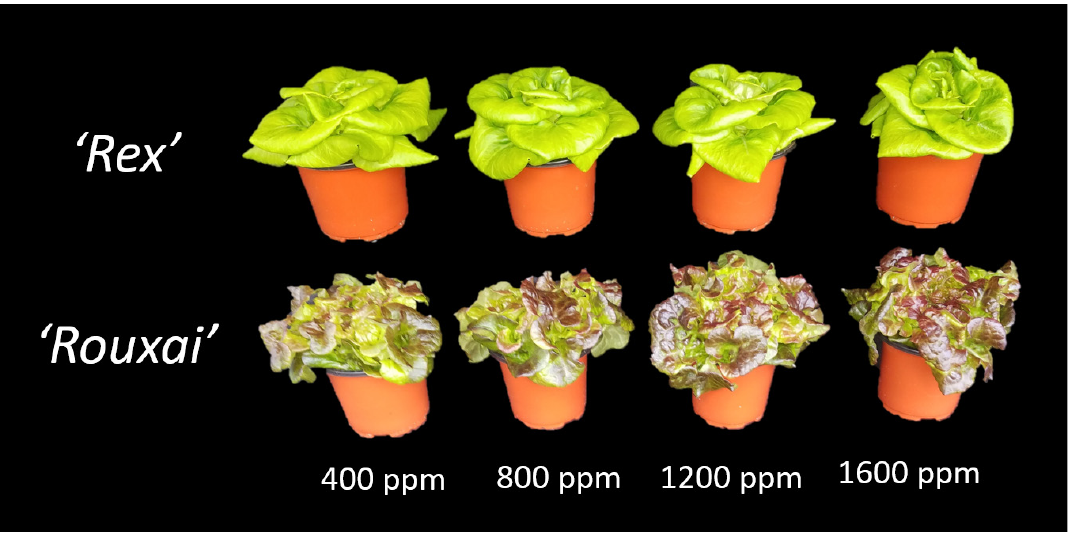
Figure 2. Representative lettuce plants on the day of harvest. The top four plants are ‘Rex’ and the bottom four plants are ‘Rouxai’. Plants are arranged in order of increasing CO 2 concentration from left to right.